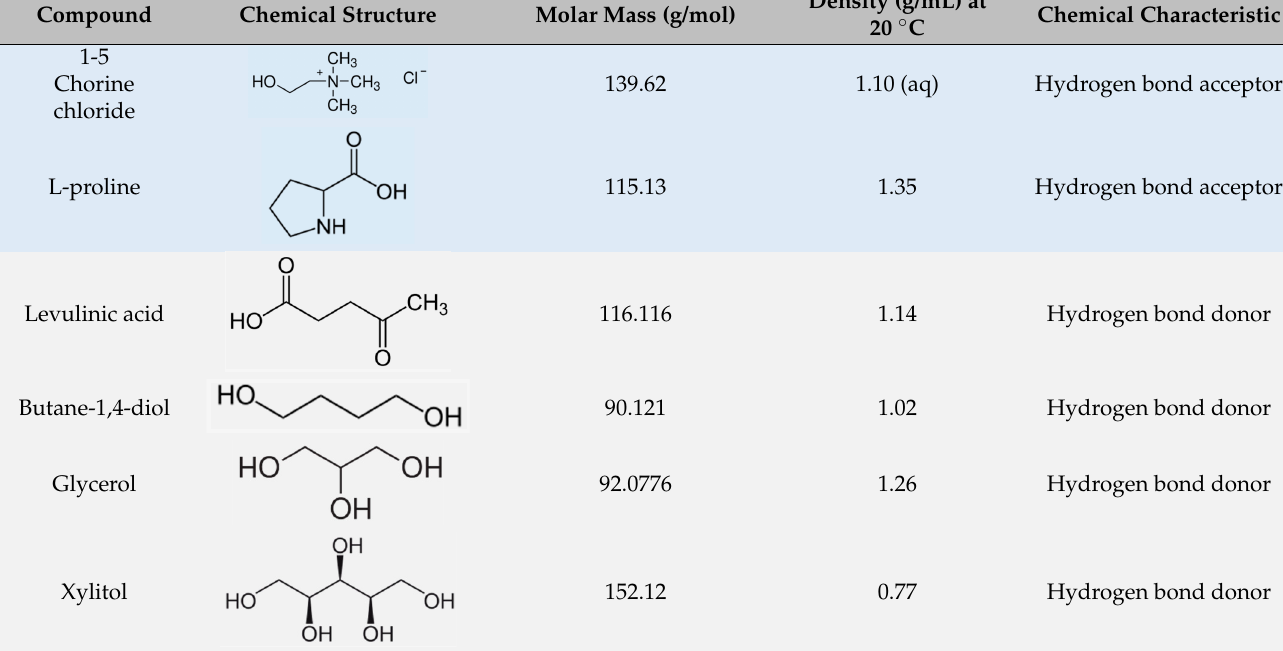
Table 1. Properties of the compounds used to create deep eutectic solvents .